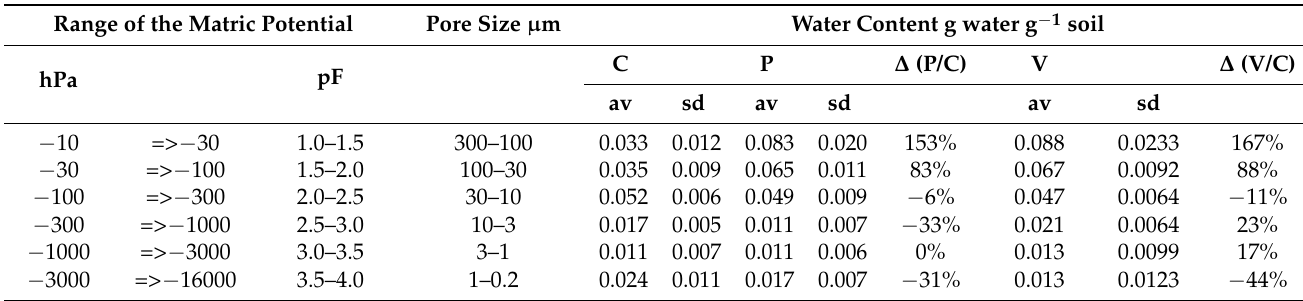
Table 6. Water content (g water g − 1 soil) at different matric potentials in the top layer of the unamended control, compost and vermicompost added